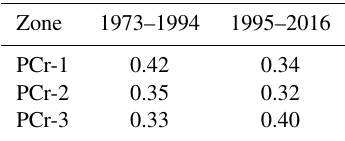
Table 1. Acceptance rates from the Metropolis–Hastings